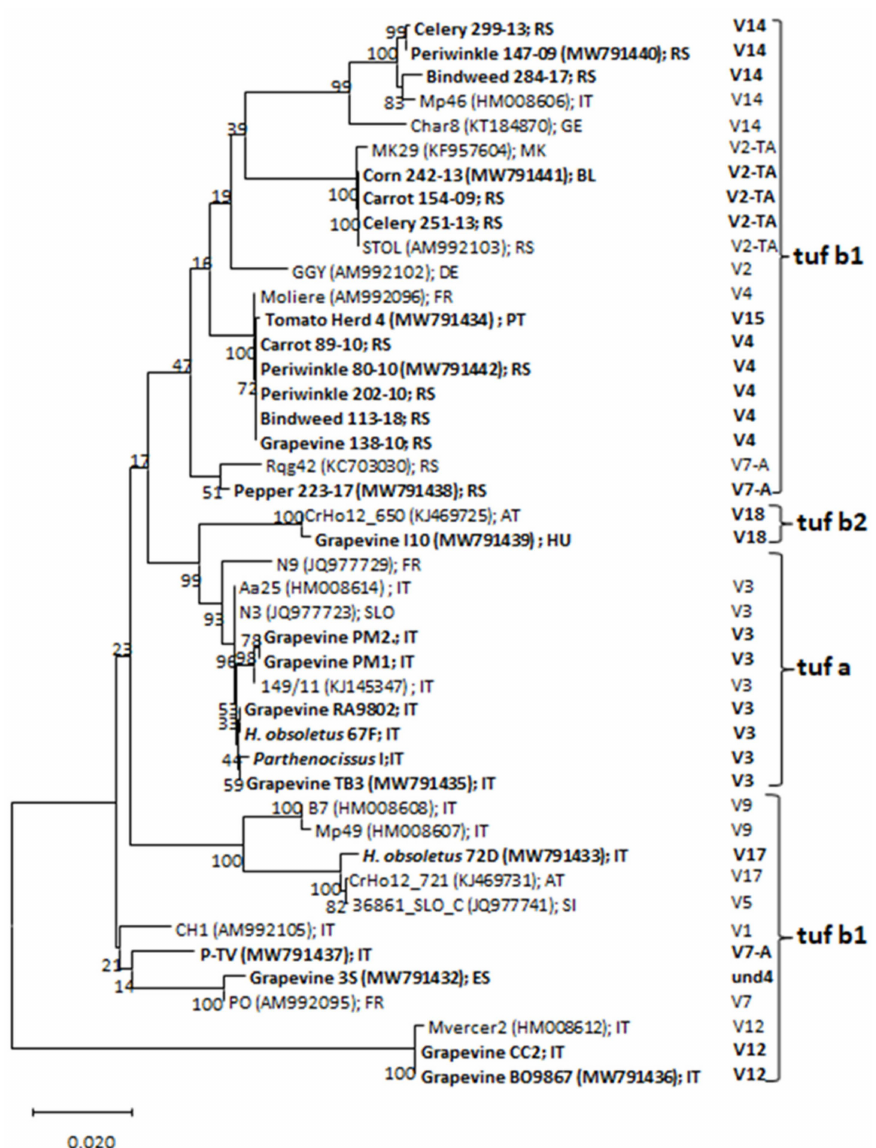
Figure 1. Unrooted phylogenetic tree inferred from the ‘ Ca. P. solani’ strain nucleotide sequences of the vmp1 gene. The phylogenetic analysis was carried out using the neighbor-joining method and bootstrap-replicated 1000 times. The phytoplasma strain acronyms are given in the tree. The GenBank accession number of each sequence is given in parentheses; gene sequences obtained in the present study are indicated in bold. Rsa I-V vmp1 gene profiles are reported next to the tree. Clusters according to tuf types are also shown on the right. AT, Austria; BL, Bulgaria; DE, Germany; ES, Spain; FR, France; GE, Georgia; HU, Hungary; IT, Italy; MK, Macedonia; PT, Portugal; RS, Serbia; SLO,